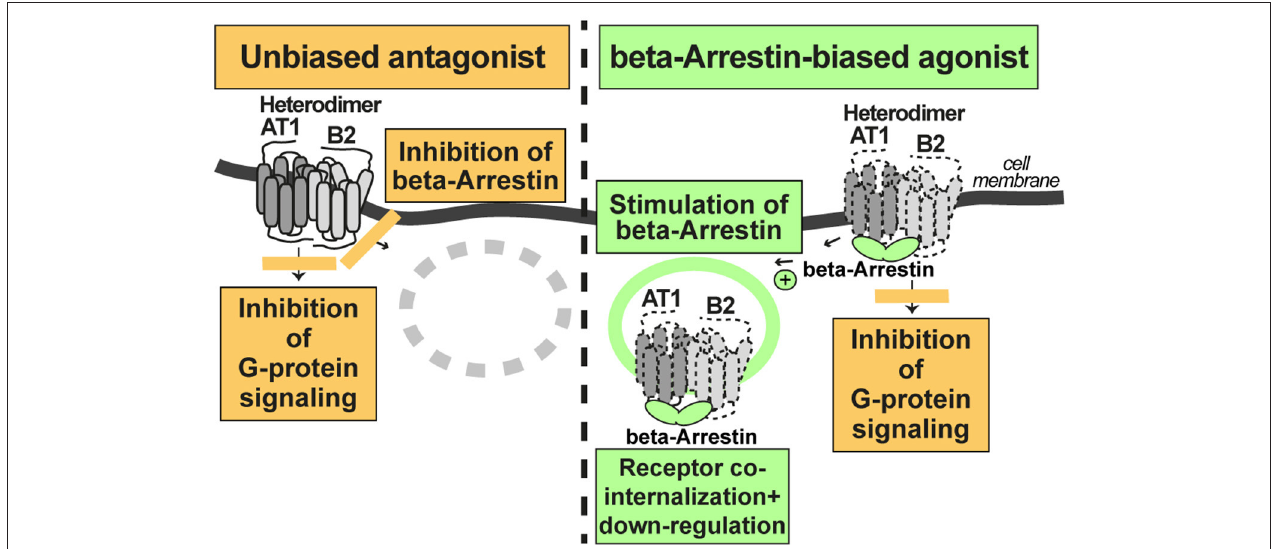
FIGURE 3 | A beta-arretin-biased agonist targets the AT1-B2 heteromer and promotes AT1-B2 down-regulation (right) . The unbiased AT1 antagonist does not promote AT1-B2 down-regulation (left) .